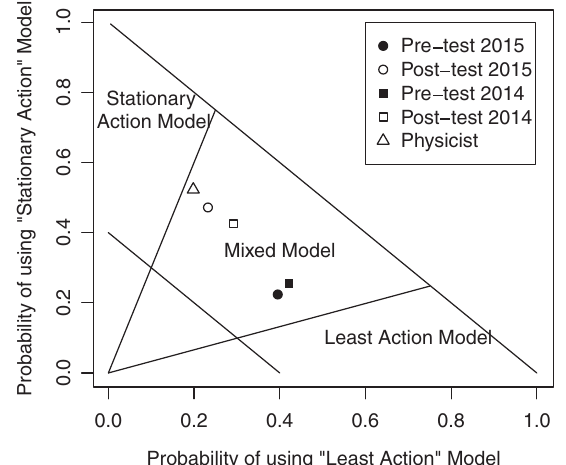
FIG. 2. Model plot of the probability of students using the correct principle of stationary action conceptual framework versus their probability of using the incorrect least action framework. The lines somewhat arbitrarily separate the plot into three regions corresponding to different conceptual frameworks [26]: they are where the sum of the two probabilities are 0.4 or 1, and where one probability is 3 times the other. All results are in the mixed model region, meaning that individuals were using either the stationary action or least action models, depending on the